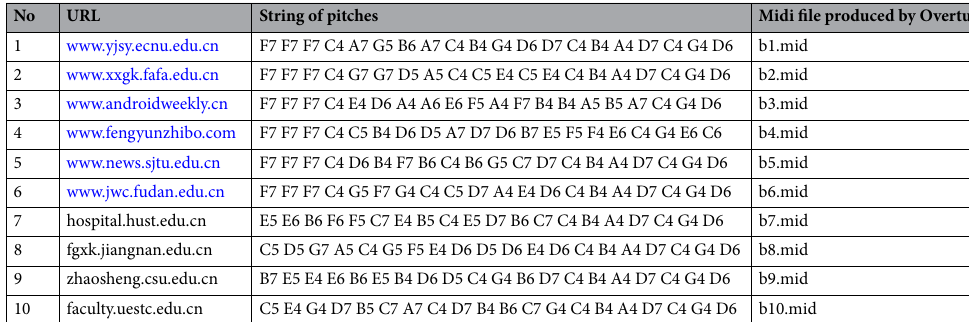
No URL String of pitches Midi file produced by